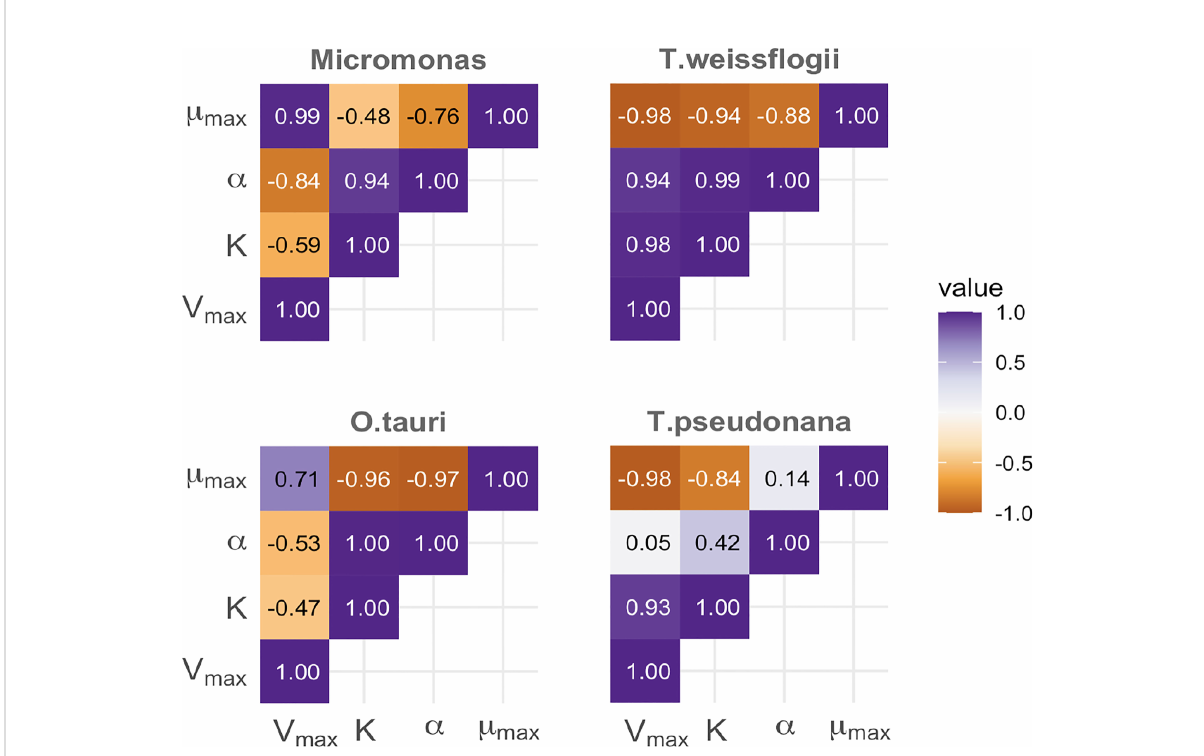
FIGURE 4 A comparison of the correlation between parameters estimated using the Monodmemory model for each of four taxa, demonstrating differences between prasinophyte (left column) and diatoms (right) with smaller differences between taxa within these groups (top and bottom).